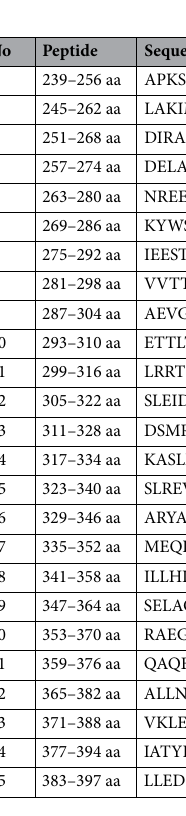
Table 1. Sequence of peptides for epitope mapping. aa amino acid